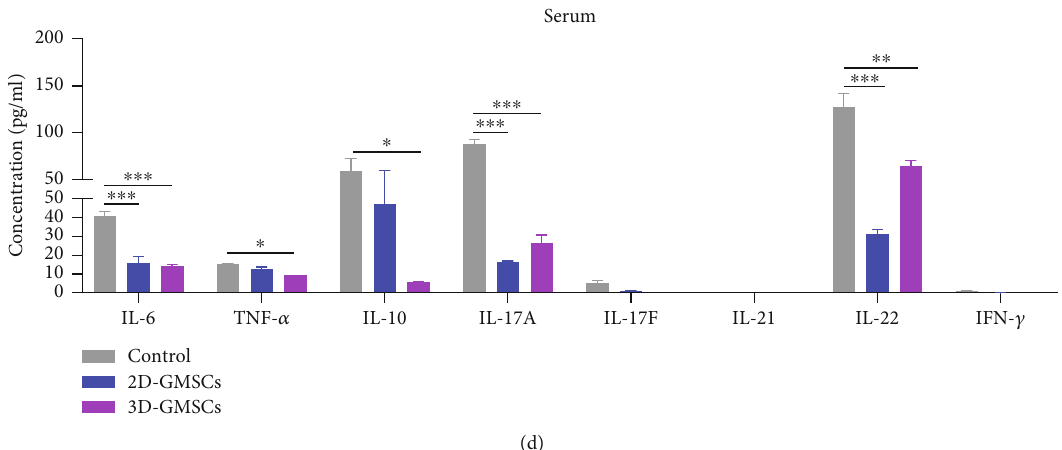
Figure 5: GMSCs strongly in fl uence the expression of serum in fl ammatory mediators and spleen CD25 + CD3 + and IL-17 + CD3 + T cell responses. (a) Representative photographs of spleen and the ratio of spleen weight to bodyweight in di ff erent groups. ∗ p < 0 : 05 ; ∗∗ p < 0 : 01 . (b) Representative fl ow cytometry staining for CD25 and IL-17A in CD3 + T cells from mouse spleen. (c) Quanti fi cation of percentage of CD25 + CD3 + T cells and IL-17A + CD3 + T cells from fl ow cytometry data. ∗ p < 0 : 05 . (d) The protein expression level of in fl ammatory cytokines in the serum evaluated via multiplex LEGENDplex analysis. ∗ p < 0 : 05 ; ∗∗ p < 0 : 01 ; ∗∗∗ p < 0 : 001